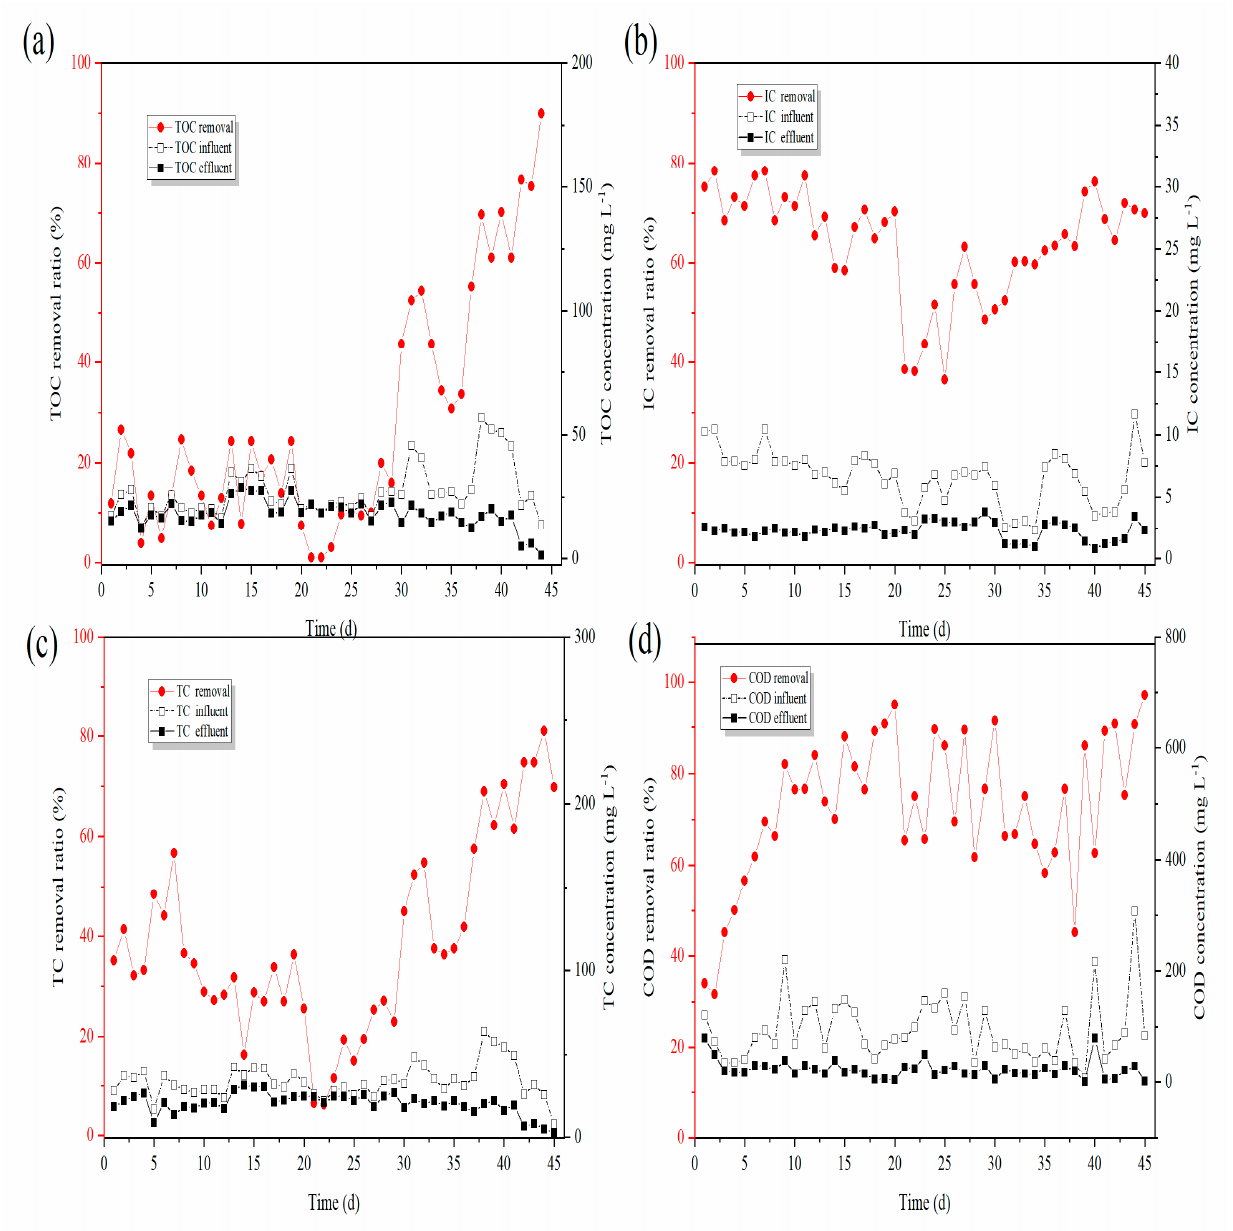
Figure 2. Decarburization efficiency of the MBR based on the TOC ( a ), IC ( b ), TC ( c ), and COD ( d ) concentrations.